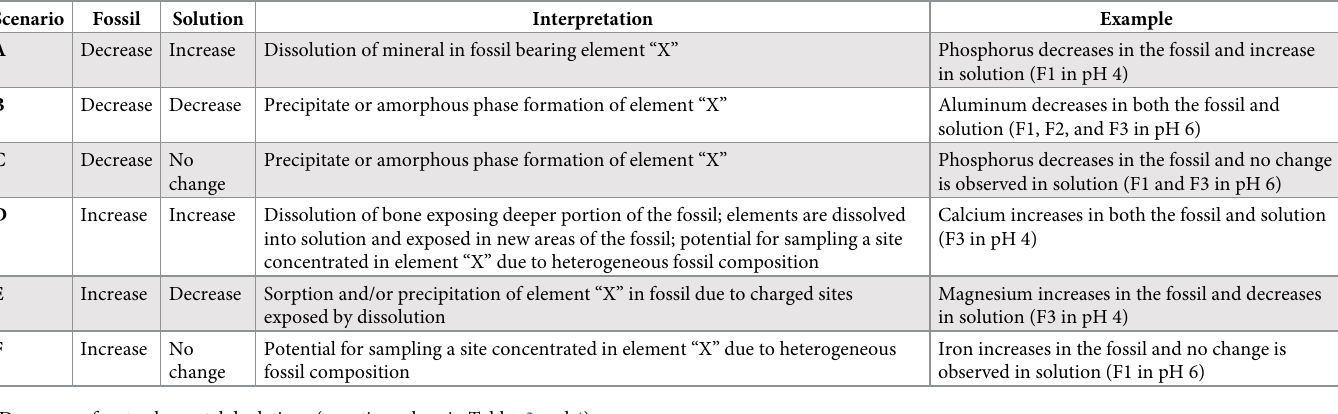
Table 7. Interpretation of elemental relationships between fossil and solution samples, based on data presented in Tables 3 and 4 a,b,c